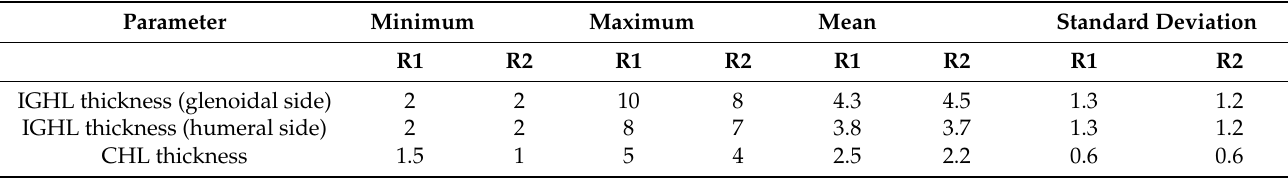
Table 4. Summary of patients’ MRI